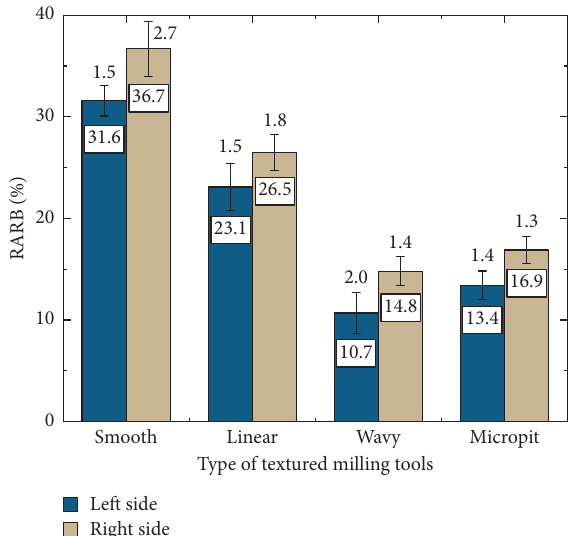
Figure 8: RARB of the workpieces after milling with different textured